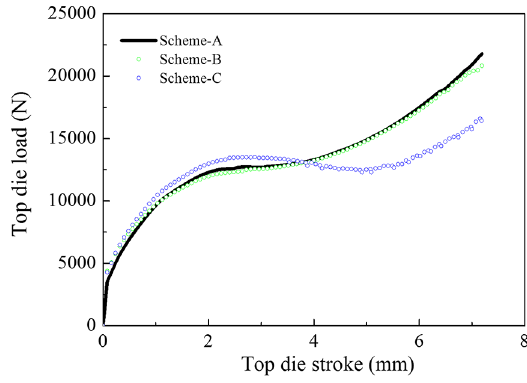
Figure 11. The corresponding relationship between the stroke and the loading force of top die for the three